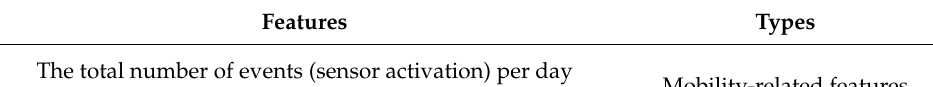
Table 7. Day-level activity features applied in our study (revised from [45]).